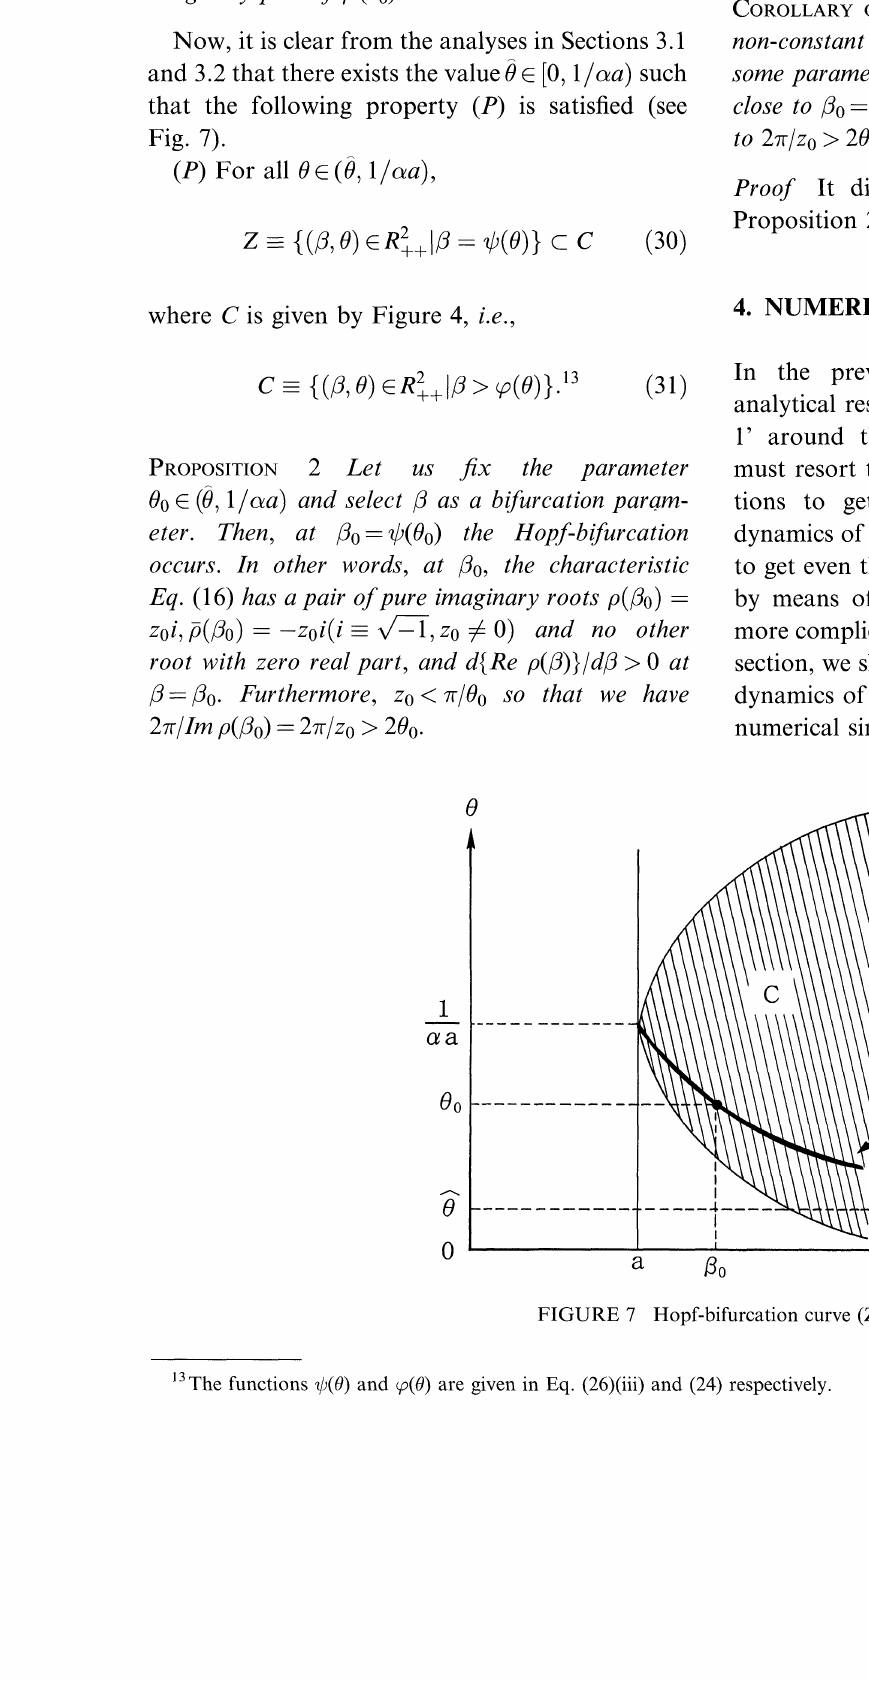
FIGURE 7 Hopf-bifurcation curve